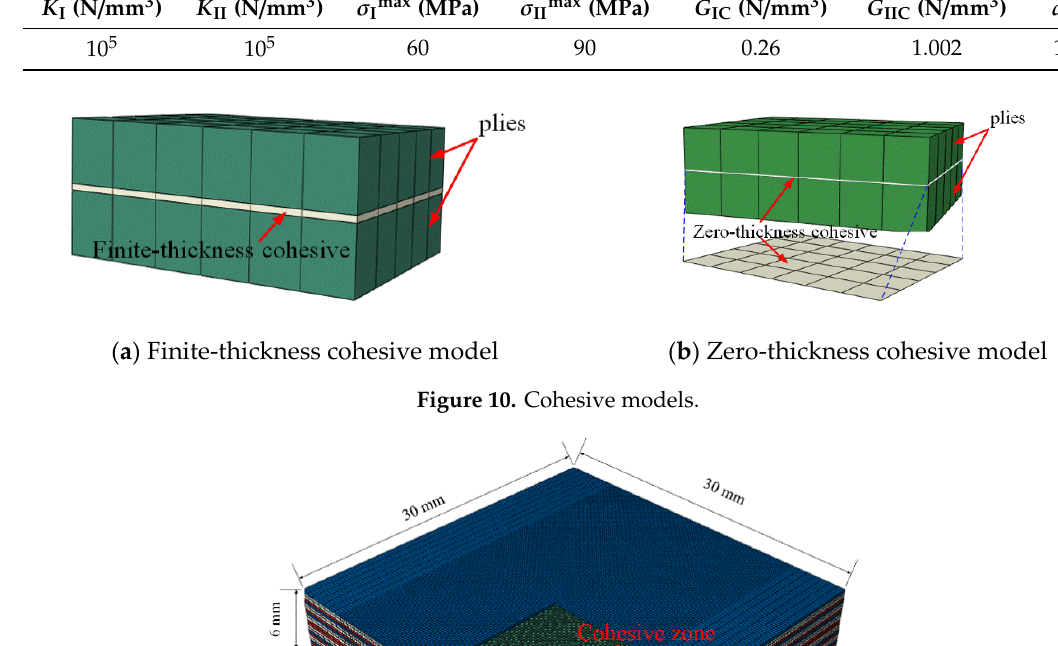
Figure 10. Cohesive models.